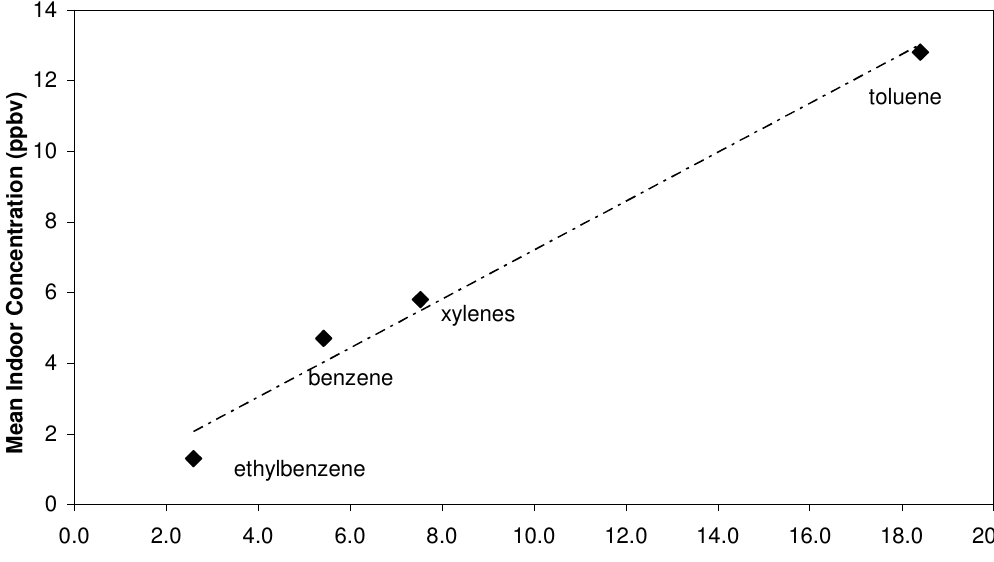
Figure 1. Comparison of Anchorage gasoline BTEX composition with concentration in indoor